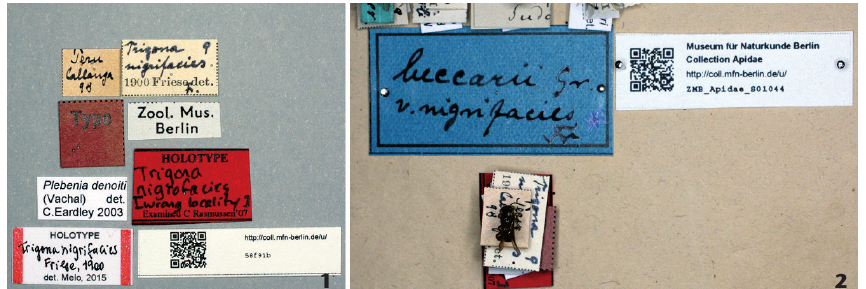
Figures 1-2. Plectoplebeia nigrifacies : (1) labels of the holotype of Trigona nigrifacies Friese, 1900; (2) place under which the holotype of T. nigrifacies was found in the ZMB